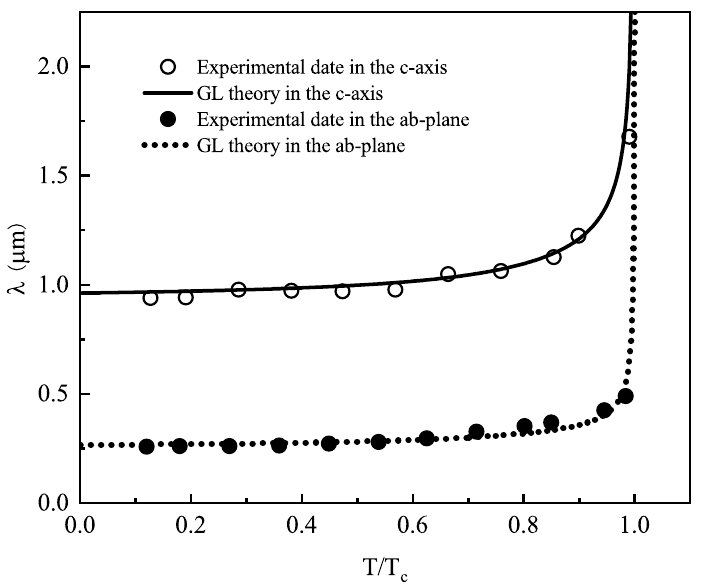
Figure 2. Magnetic penetration depth along the c -axis (solid line) and in the ab -plane (dotted line) as function of temperature. The experimental data are from Ref.